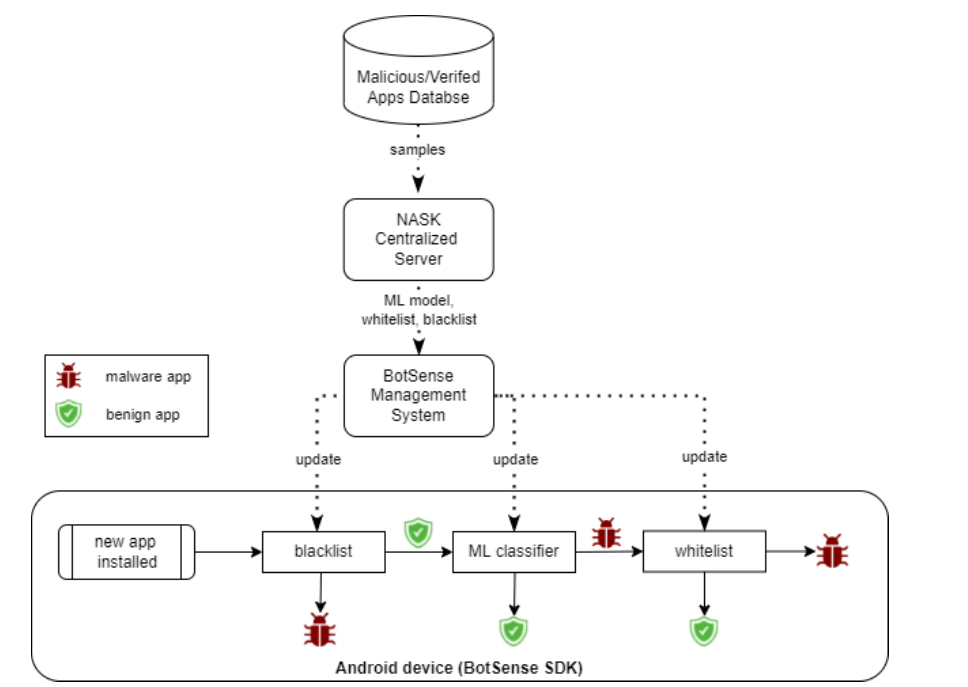
Figure 2. Malware detection module